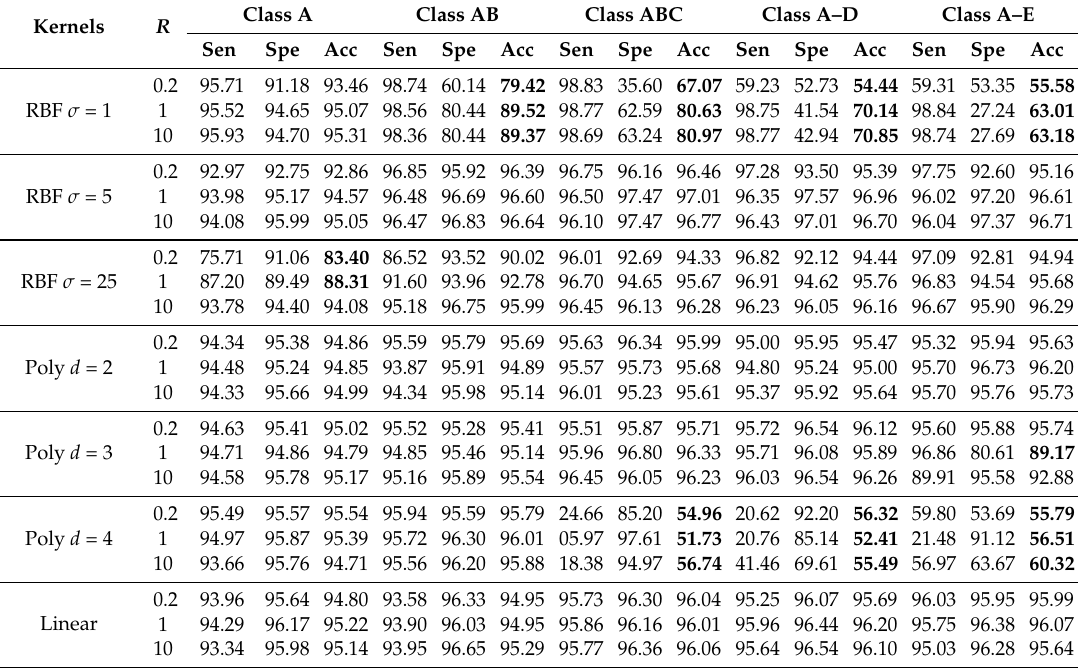
Table 3. Means (00.00%) of sensitivity specificity and accuracy of the k -fold method based on the feature classes using SVM models with different kernel functions and parameters (the worse accuracy ( ≤ 90%) is highlighted in